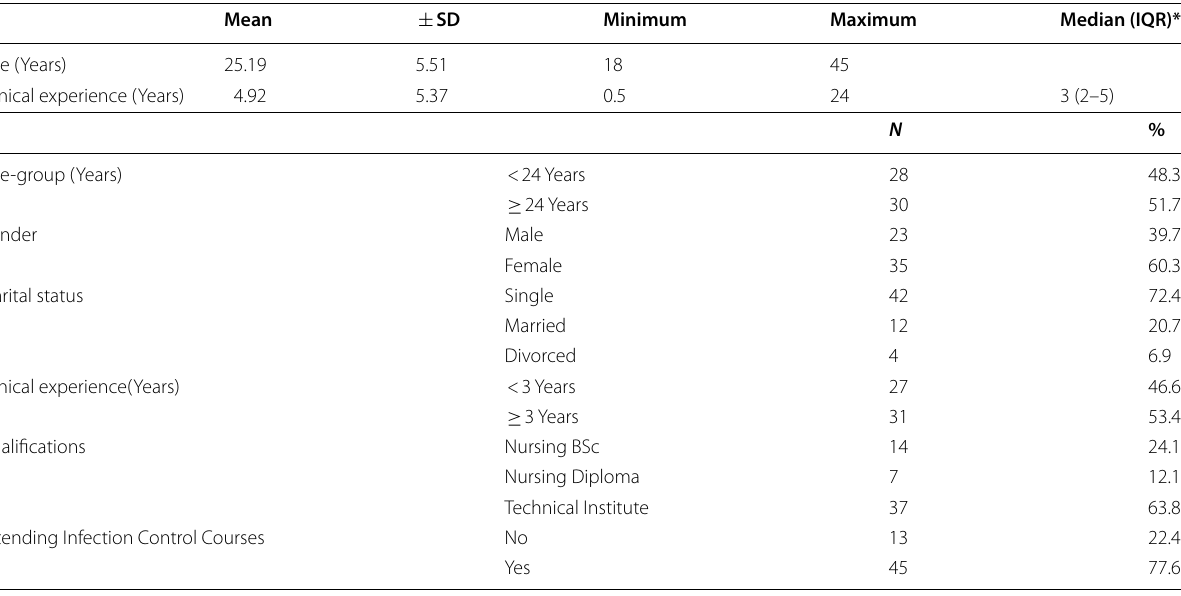
*Interquartile range